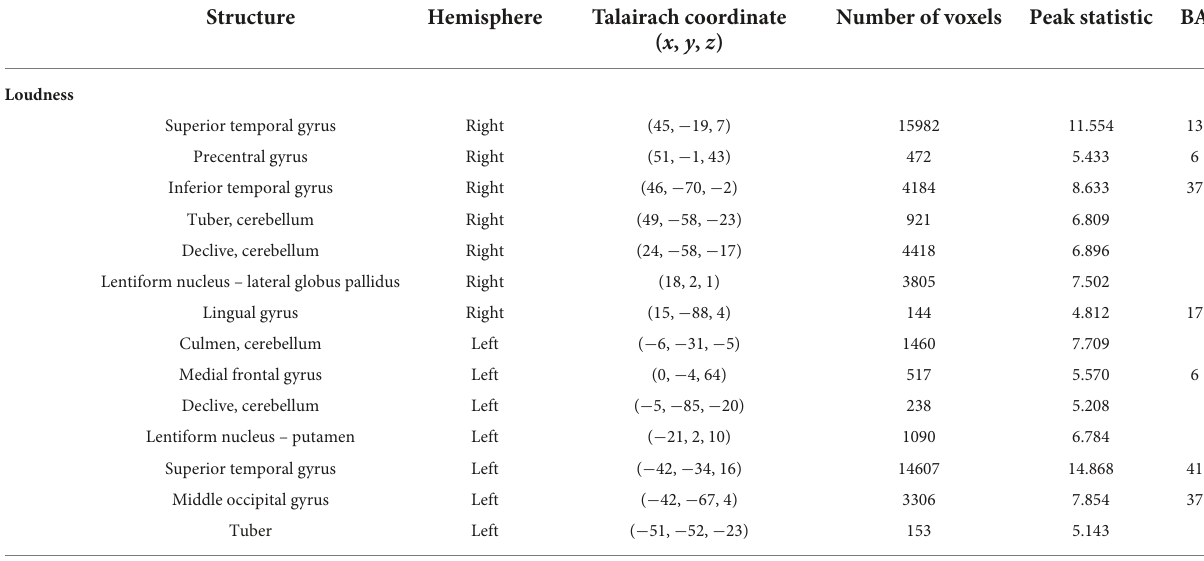
Number of voxels Peak statistic BA ( x , y , z )